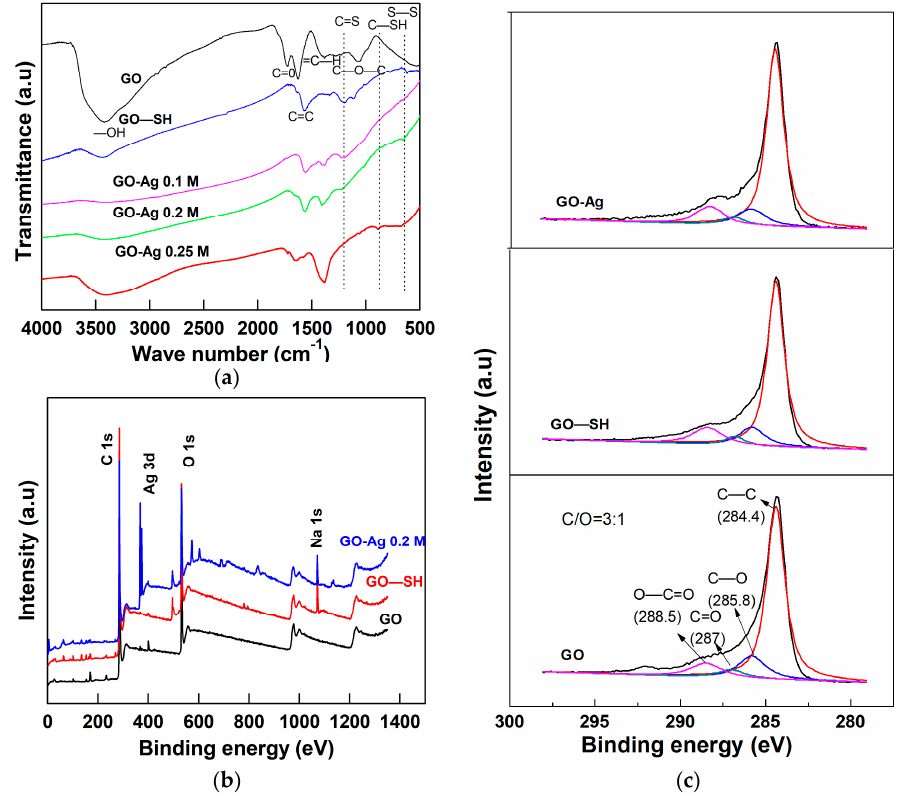
Figure 4. FTIR analysis of ( a ) GO, GO–SH, GO-Ag 0.1 M, GO-Ag 0.2 M, and GO-Ag 0.25 M composites; ( b ) XPS full scans of GO, GO–SH, and GO-Ag 0.2 M composites; and ( c ) C 1s deconvolution spectra of GO, GO–SH, and GO-Ag 0.2 M composites.